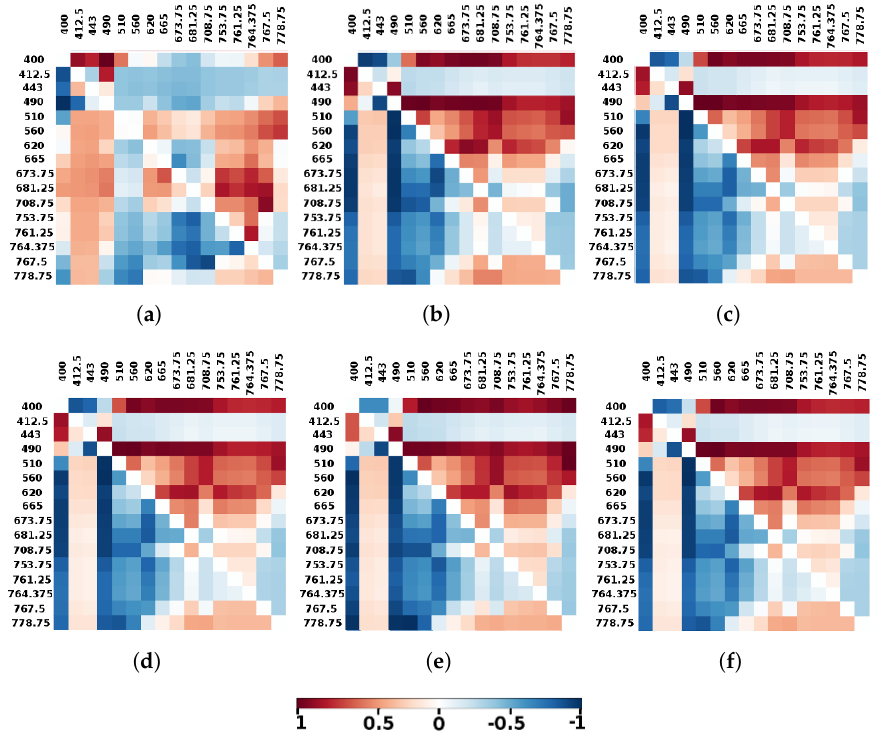
Figure 6. Correlation matrices depicting relationships between combinations of logarithms of the OLCI remote sensing reflectance band ratios and logarithms of the relevant water properties. Absorption by CDOM at 443 nm ( a ), chlorophyll a concentration ( b ), absorption by particles at 443 nm ( c ), absorption by particles at 670 nm ( d ), total absorption at 443 nm ( e ), total absorption at 670 nm ( f ). Predictions based on simulated OLCI bands.